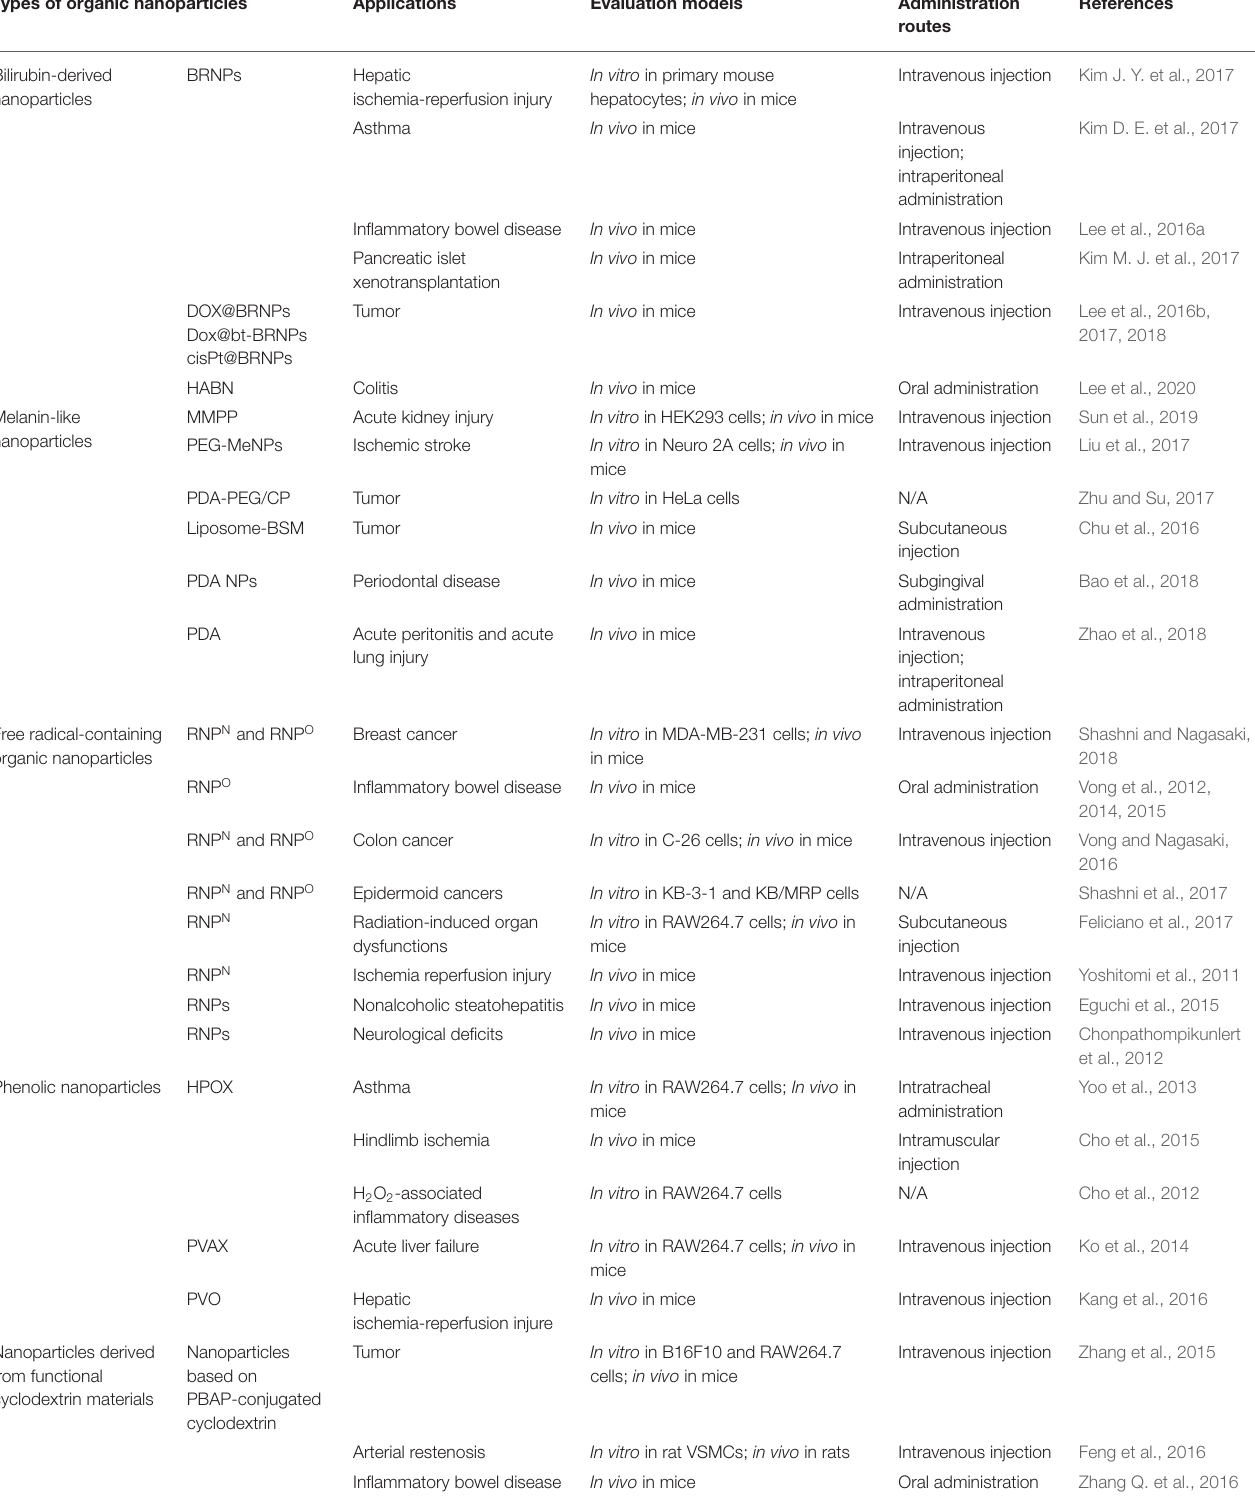
TABLE 2 | Different organic nanoparticles with intrinsic antioxidant